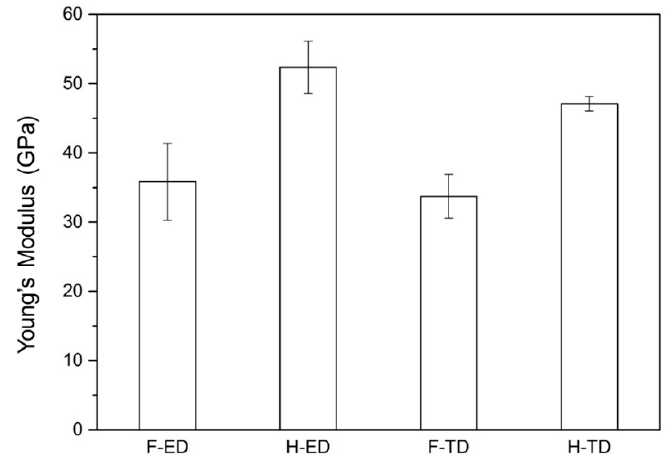
Figure 6. Young’s modulus of XK105. (H-ED: extrusion direction of XK105-H; H-TD: transverse direction of XK105-H; F-ED: extrusion of XK105-F; F-TD: transverse of XK105-F). Metals 2019 , 9 , x FOR PEER REVIEW 6 of 14